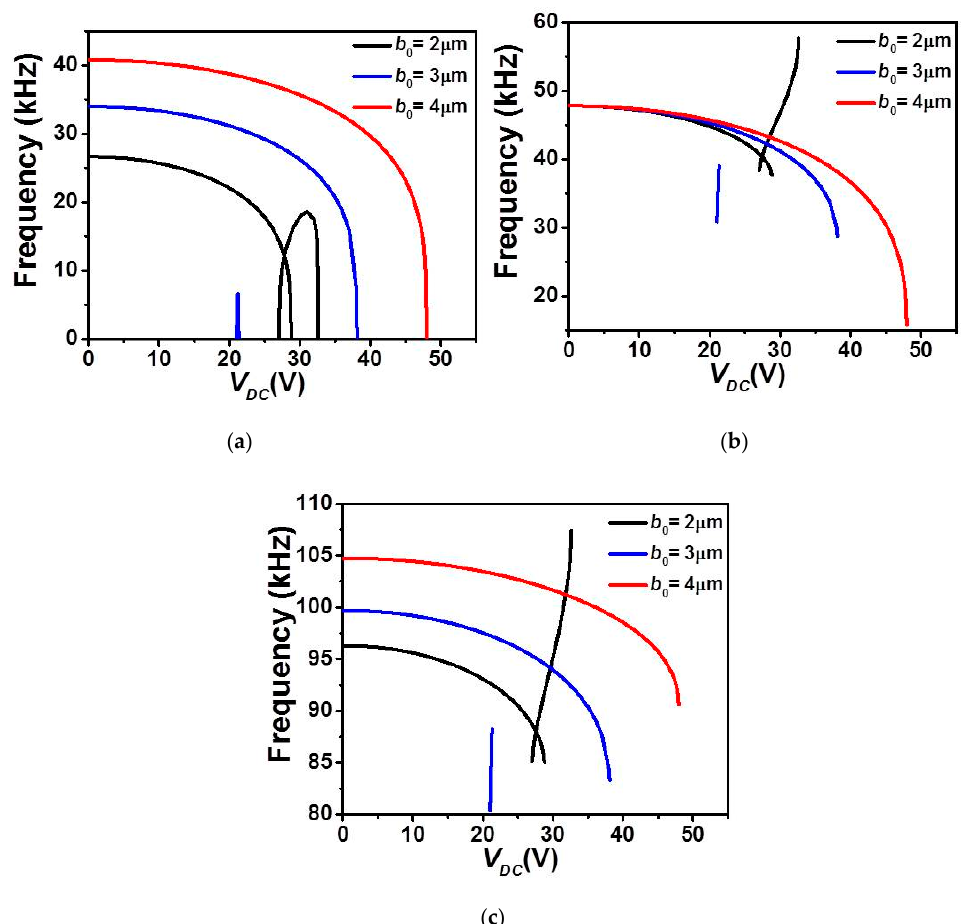
Figure 7. The variation of the ( a ) first, ( b ) second, and ( c ) third in-plane flexure natural frequencies for Case 1 as varying V DC with uniform g and for various values of b 0 .